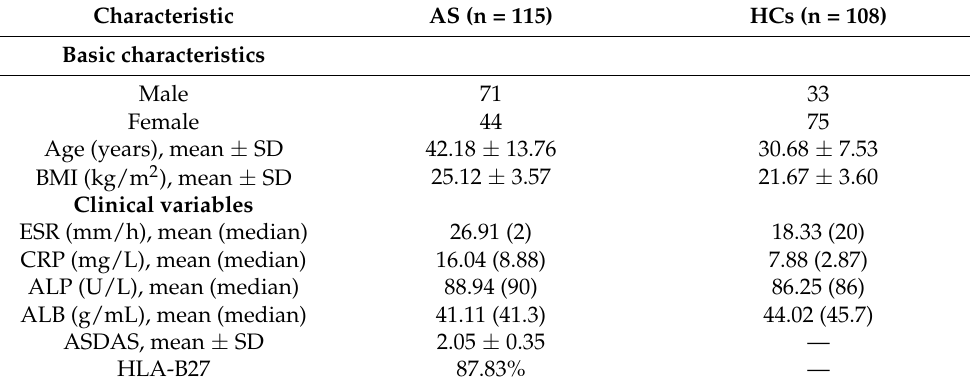
Table 1. Clinical characteristics of the subjects. Characteristic AS (n = 115) Basic